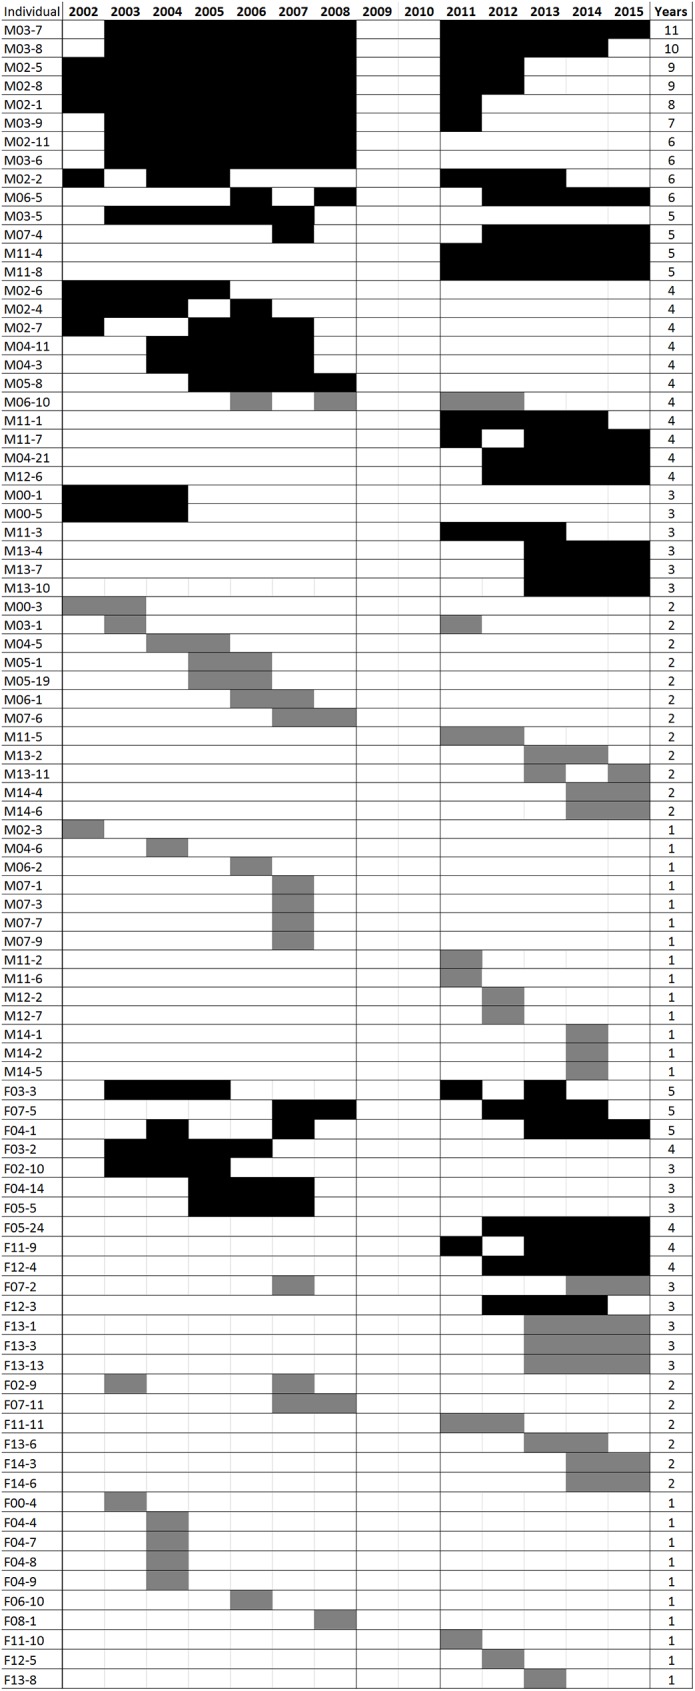
Presence per year for all adult male and female jaguars detected in the study area between 2002 and 2015 (no data for 2009 and 2010).Individuals are ordered by number of years of detection. Black bars indicate individuals detected for ≥3 consecutive years (‘residents’ of the survey area), dark grey bars represent individuals detected for ≤ 3 consecutive years (‘transients’ of the survey area).